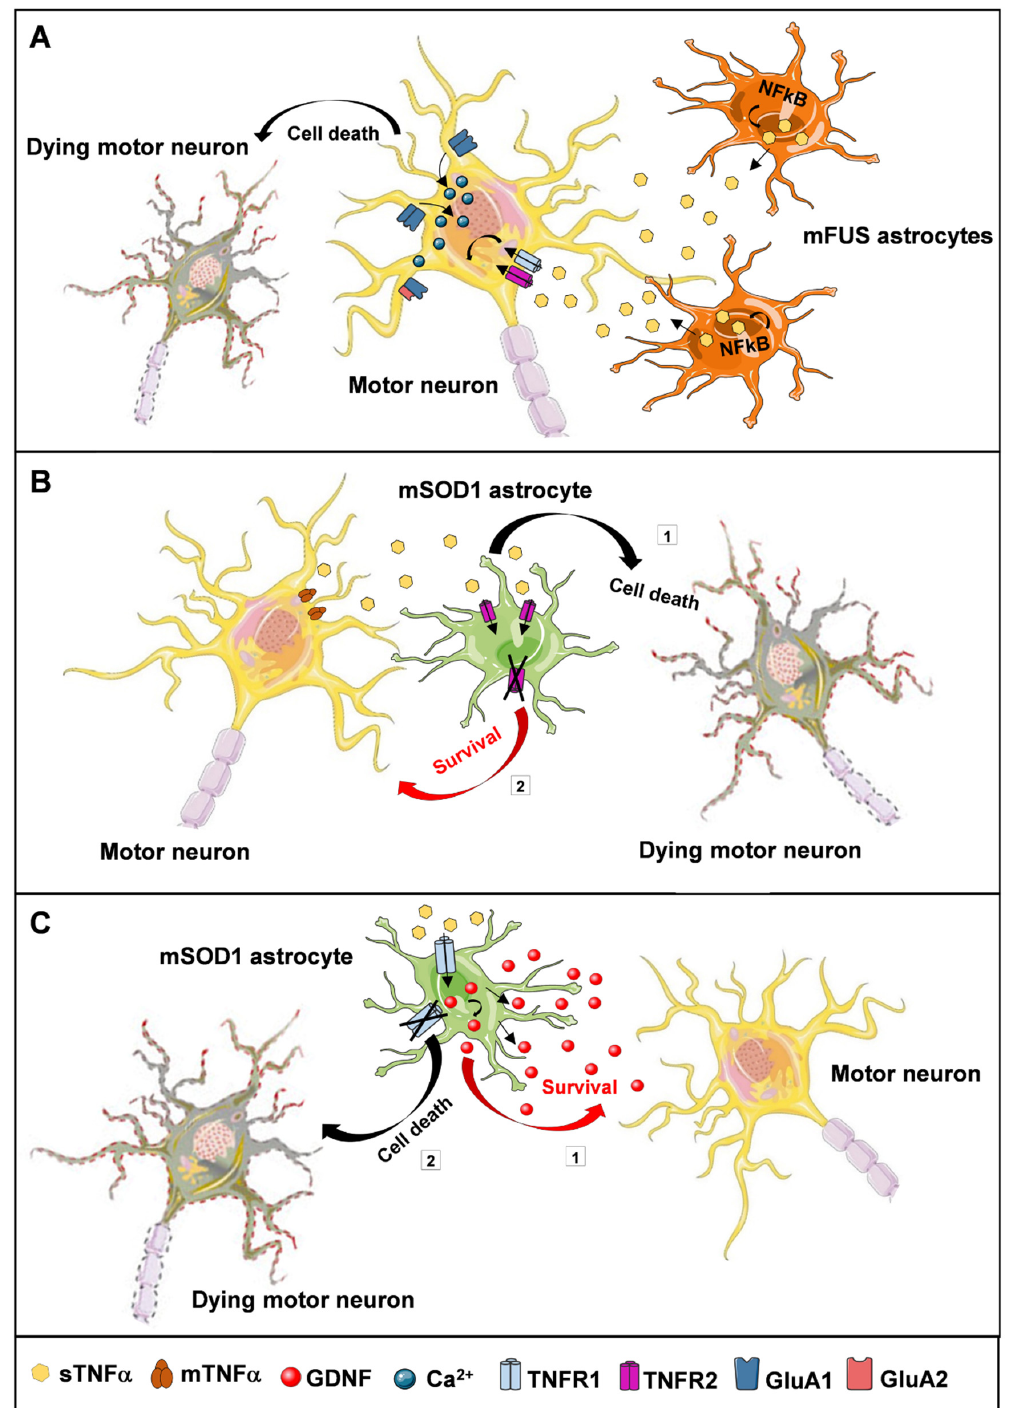
Figure 2. Representative drawing of the TNF α -dependent interactions occurring between astrocytes and motor neurons in ALS. The ways in which astrocytes can affect the conditions of motor neurons via TNF α signaling are numerous and different, depending on the receptors that are activated. ( A ) Mutant fused in sarcoma (FUS) astrocytes release a large amount of TNF α , produced by NFkB activation. This leads to an alteration in the expression levels of the AMPA receptor subunits GluA1 and GluA2, which causes an increase in intracellular calcium concentration with consequent death of motor neurons. ( B ) The stimulation of TNFR2 by TNF α shows a negative role on motor neurons, leading to their degeneration (1). Consistent with this, inhibition or ablation of TNFR2 significantly reduces neuronal cell loss (2). ( C ) Conversely, the stimulation of TNFR1 by exogenous TNF α can induce the expression and secretion of GDNF by mutant SOD1 astrocytes (1), favoring the survival of motor neurons. In keeping with this, TNFR1 deletion accelerates motor neuron degeneration